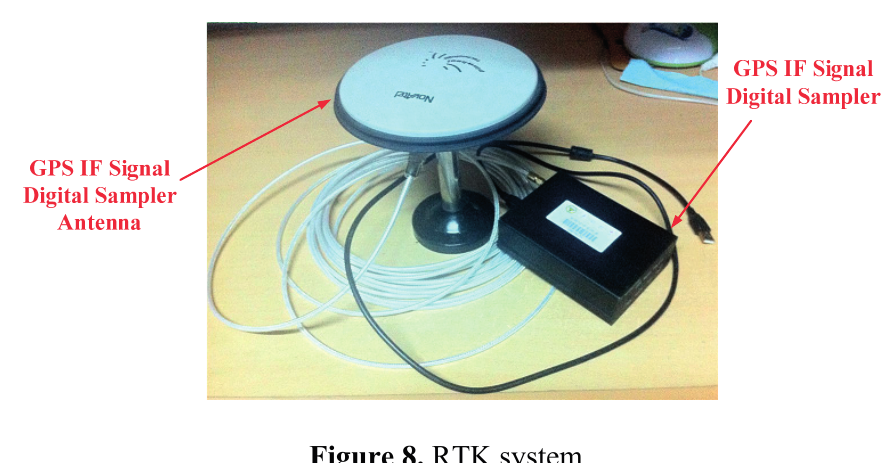
Figure 8. RTK system.